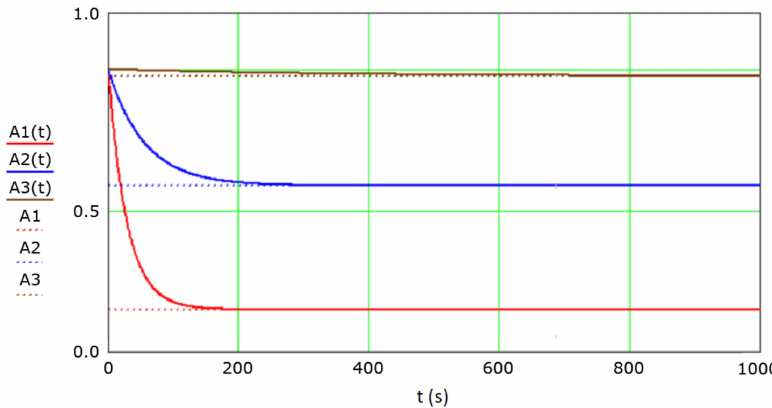
Figure 6. Availability functions: A1 ( t ), A2 ( t ), and A3 ( t ) and their limit values: A1 , A2 , and A3 . These correspond to four IHO orders: special (red colour), 1a / 1b (blue colour), and 2 (brown